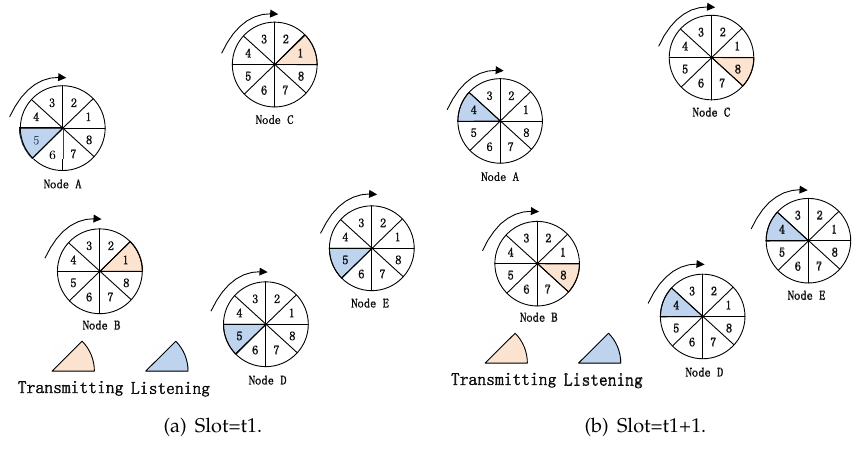
Figure 2. Illustration of traditional SBA